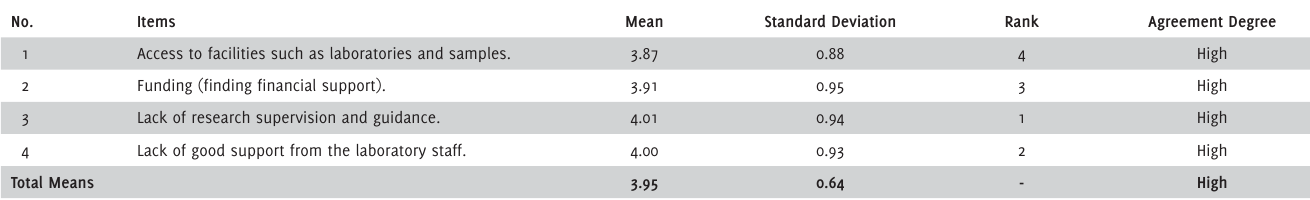
Table 3. Perceived Barriers by Medical Students to Conduct Research